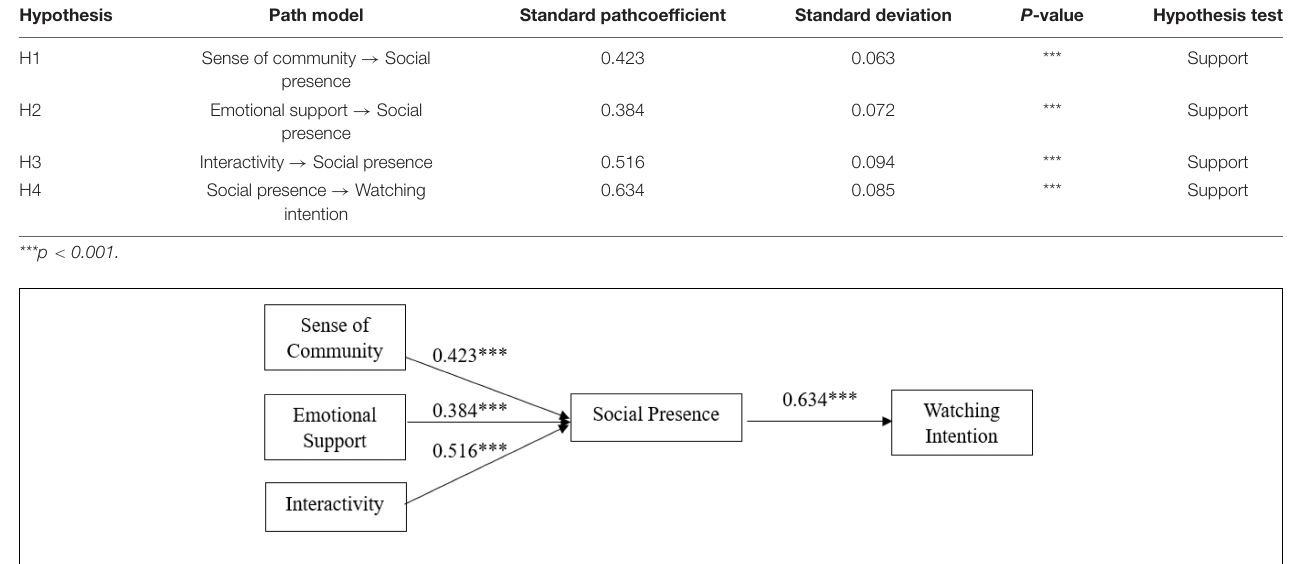
FIGURE 2 | Path coefficient test results. ∗∗∗ p < 0.001.